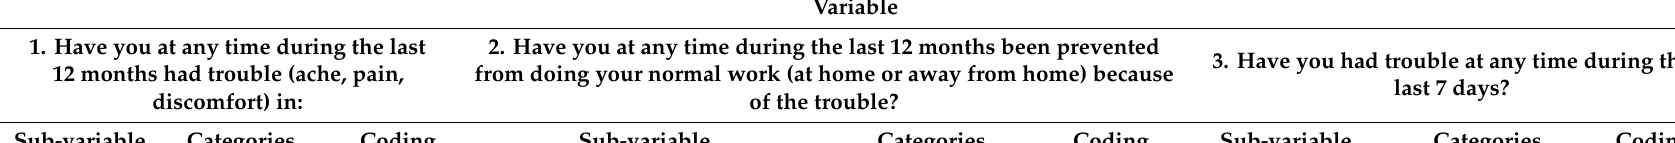
Table A1. Qualitative variables of the questionnaire